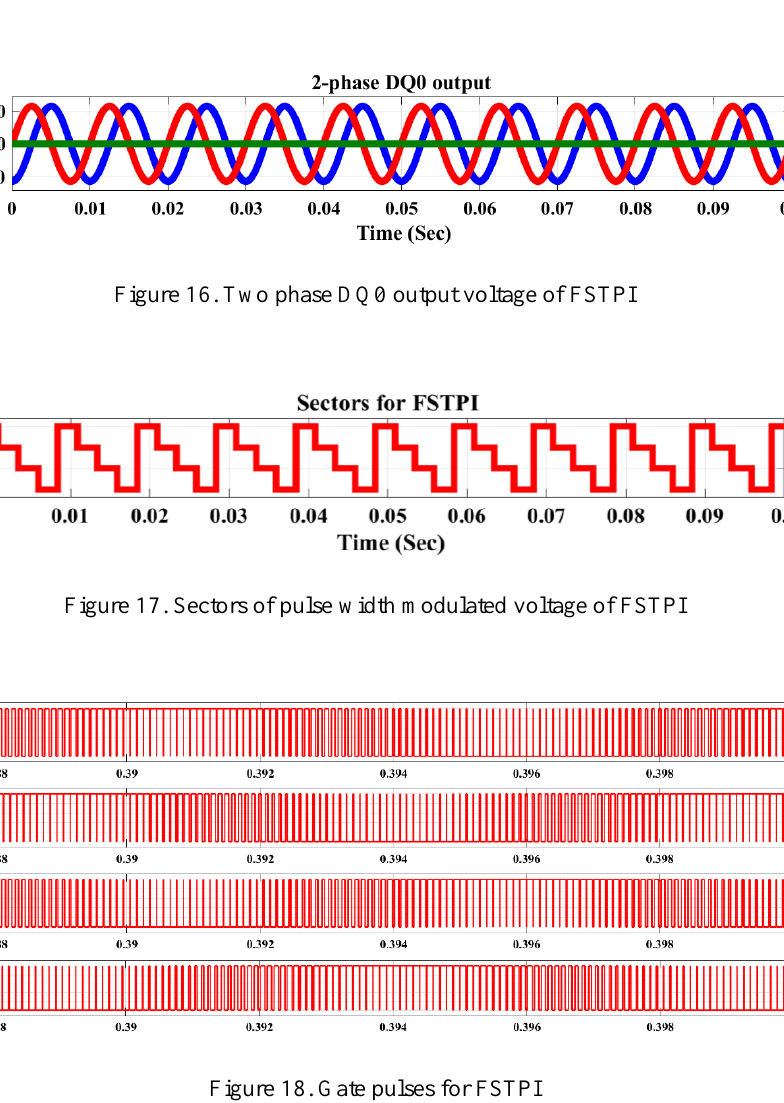
Figure 18. Gate pulses for